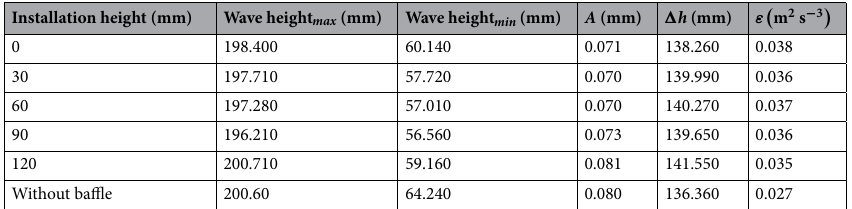
Table 1. Simulated wave pattern properties of orbitally shaken bioreactors (OSRs) at different installation height. The filling volume was 8 L and shaking speed was 100 rpm. The A was the value of interface area. The (cid:31) h was the difference between the Wave height max and the Wave height min . The ε was the energy dissipation